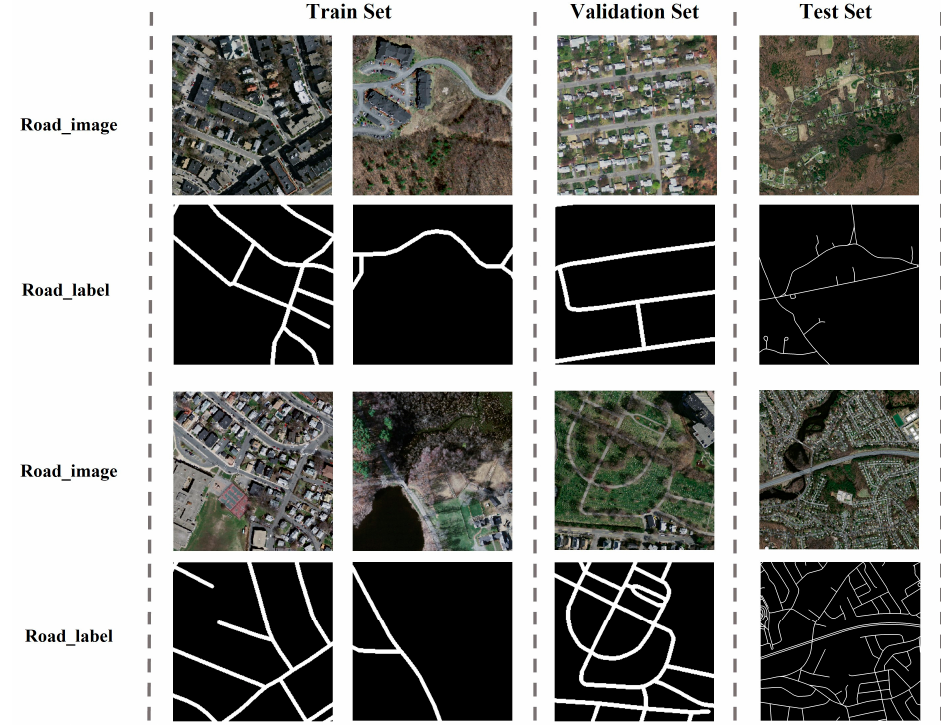
Figure 2. Massachusetts roads dataset training set, validation set and test set sample images.